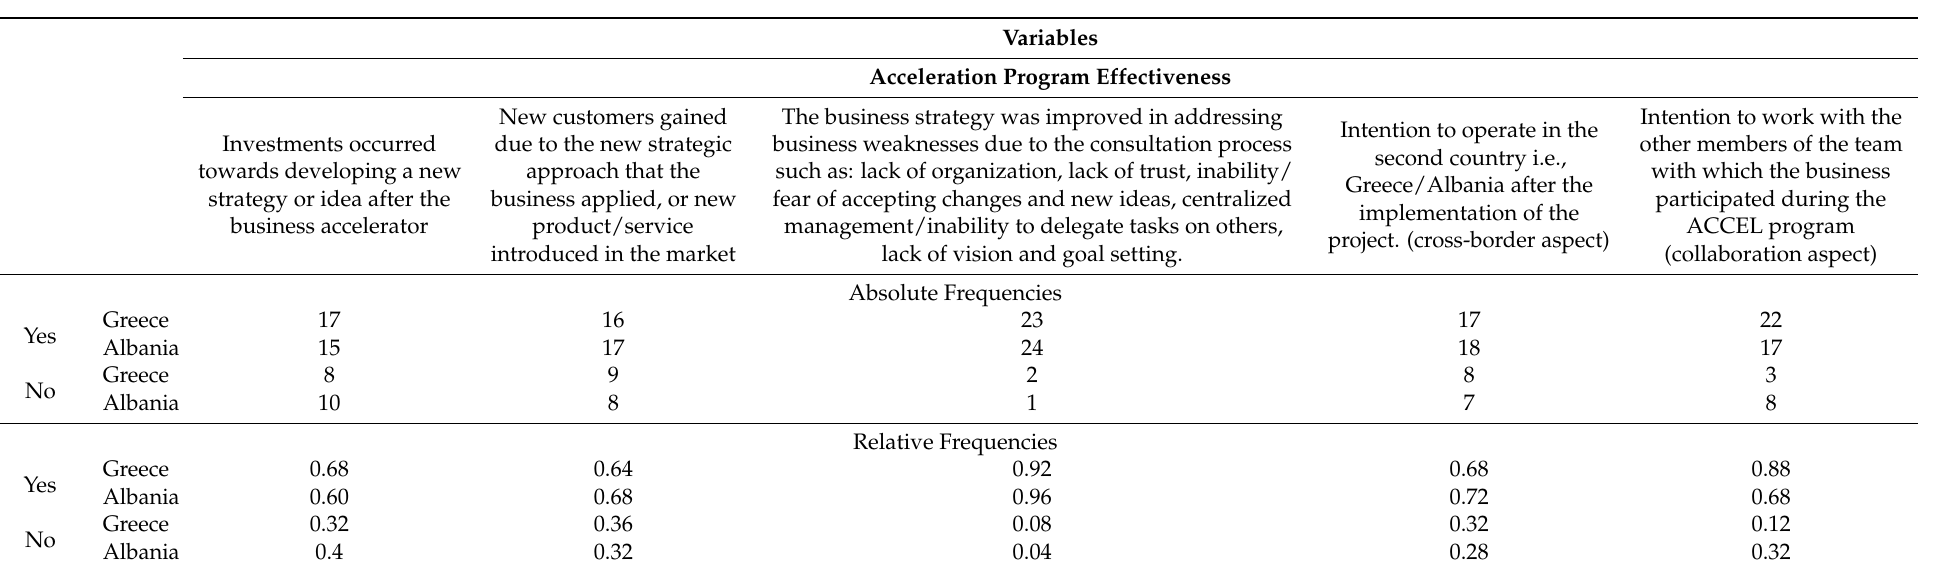
Table 3. Contigency